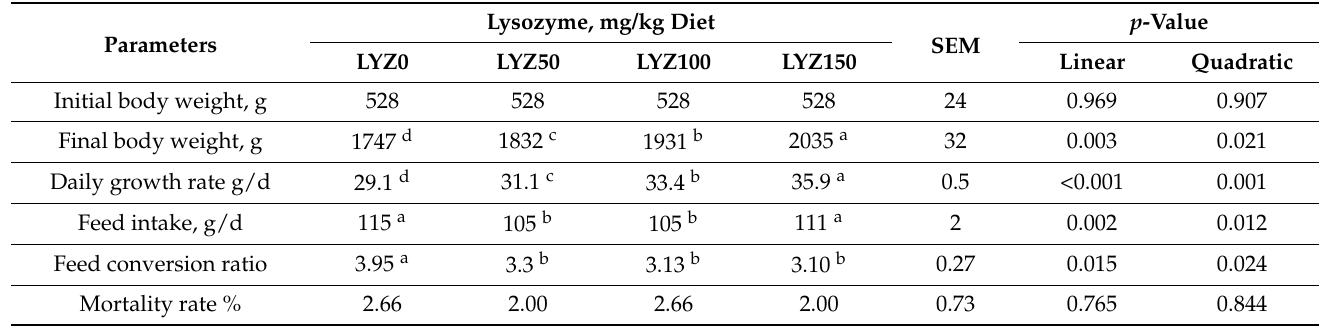
Table 2. Growth performance in growing rabbits fed diet supplemented with different levels of